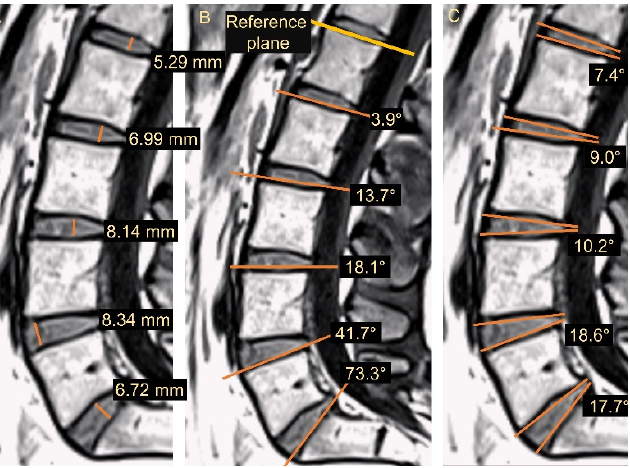
Figure 1. Illustration of the disc measures estimated in the study. ( A ) The disc height, ( B ) the tilt angle for L5–S1, and ( C ) disc angle for all IVDs.